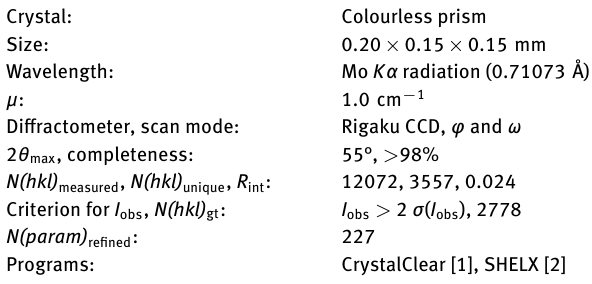
Table 2: Fractional atomic coordinates and isotropic or